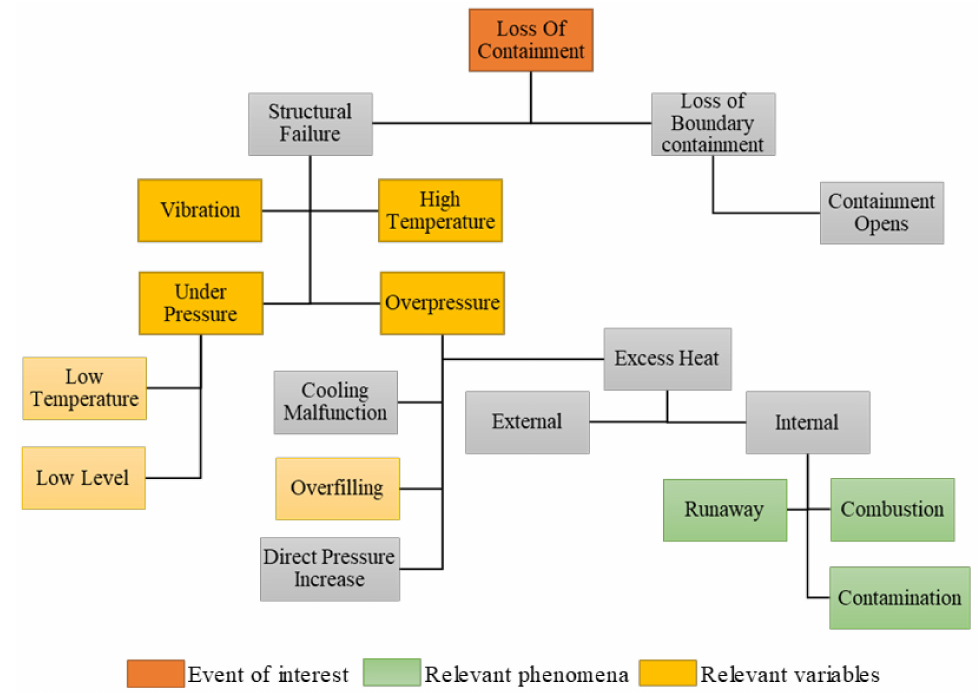
Figure 5. A simplified view of the generic master logic diagram (adapted from